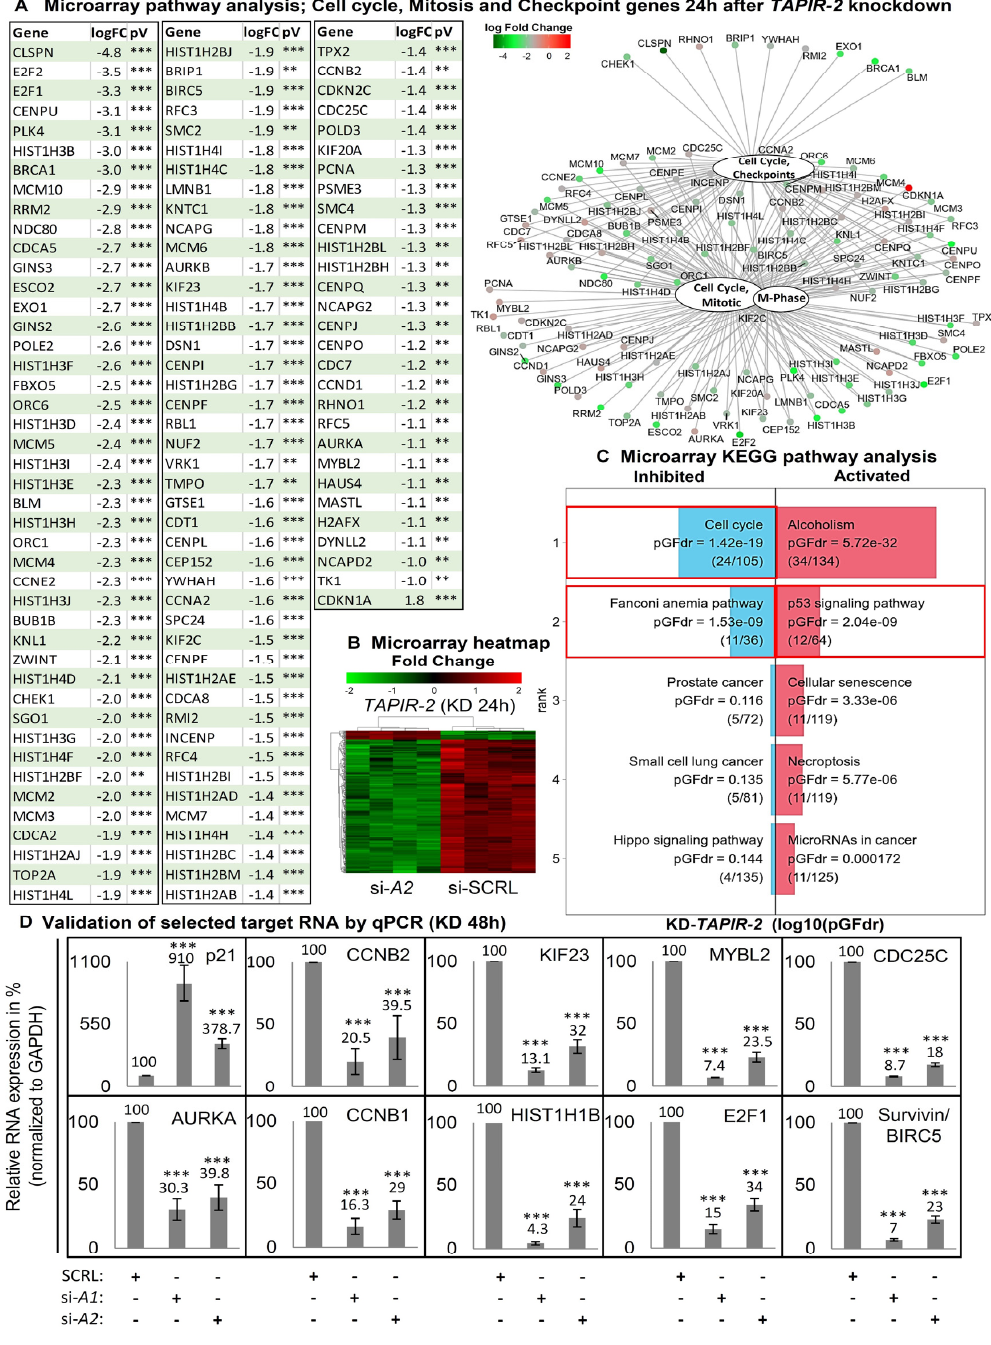
Figure 4. Increase in p53 levels and downregulation of cell cycle and DNA repair control genes following TAPIR-2 knockdown. ( A ) Differential mRNA expression following TAPIR-2 knockdown. TAPIR-2 knockdown. ( A ) Di ff erential mRNA expression following TAPIR-2 knockdown. A